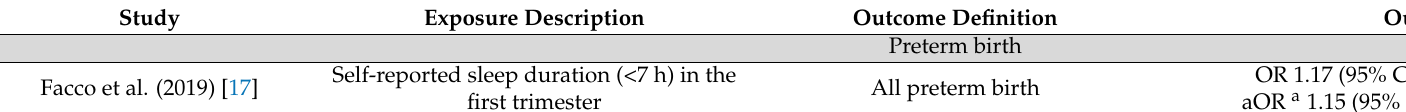
Table 3. Overview of offspring outcomes of included studies in the systematic review (N =